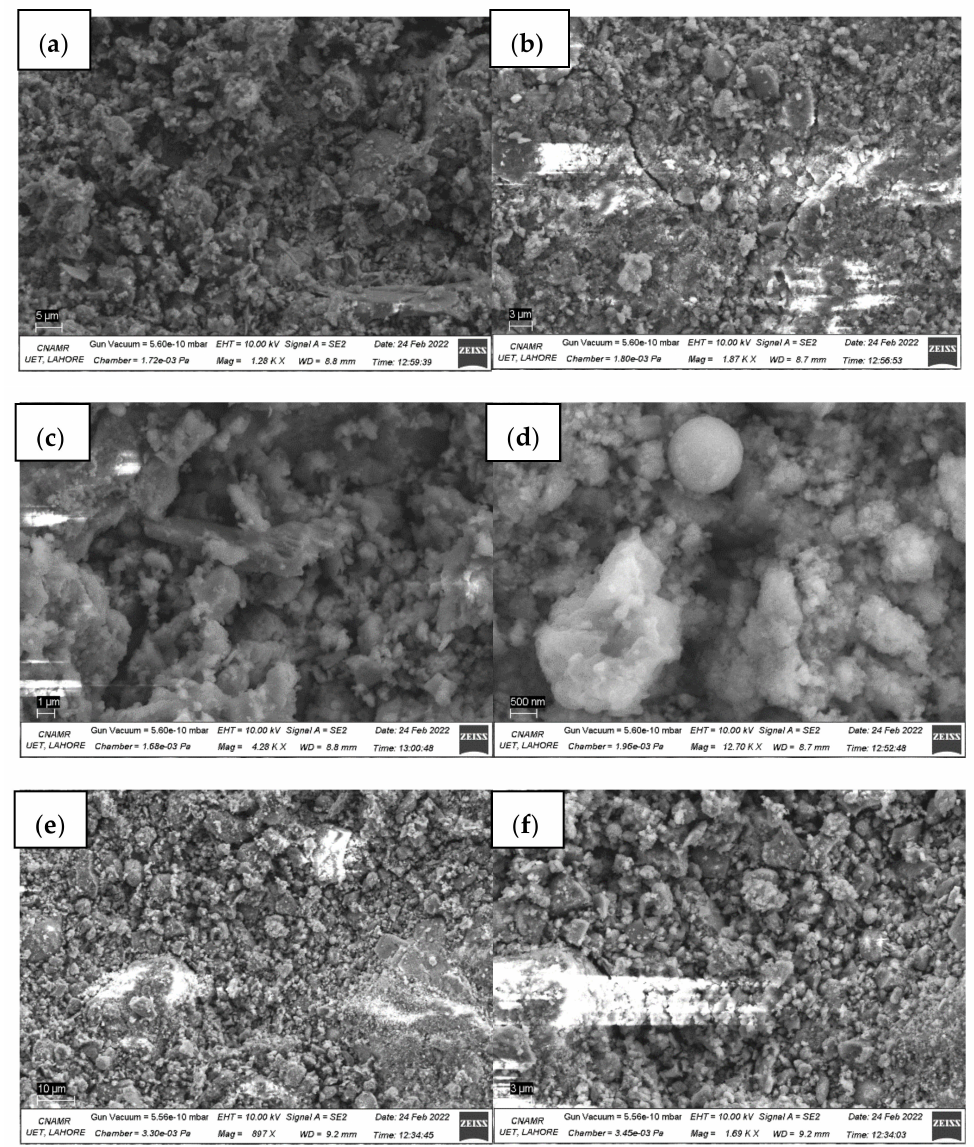
Figure 10. FESEM results for ( a ) control sample, ( b – d ) WC4% sample and ( e , f ) SiC4%